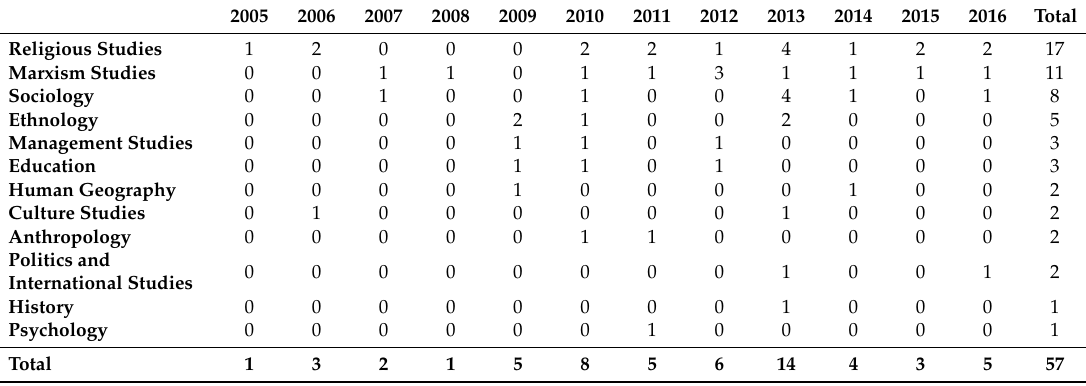
Table 2. Distribution of Academic Disciplines addressed by the Sample